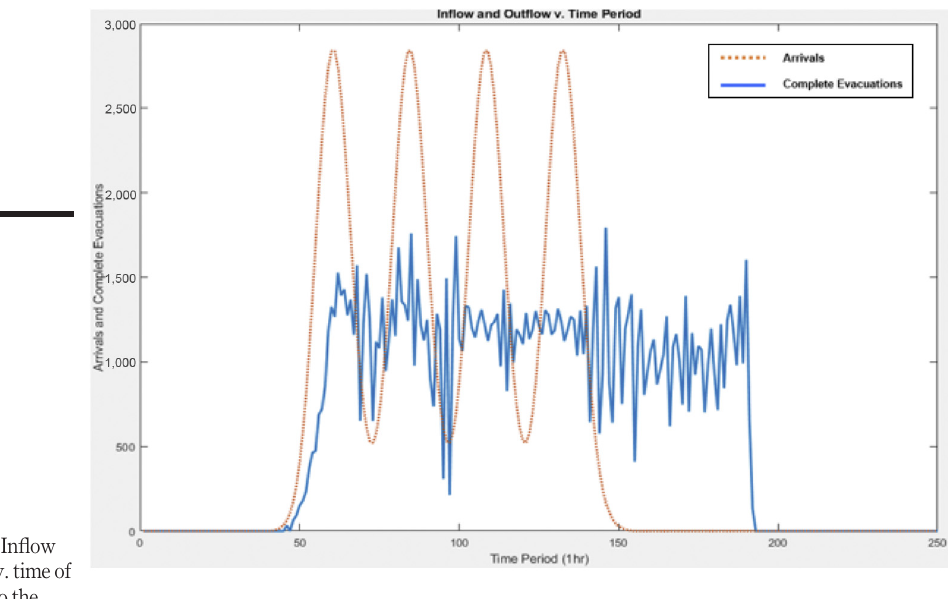
Figure 7. (color online) In fl ow and out fl ow v. time